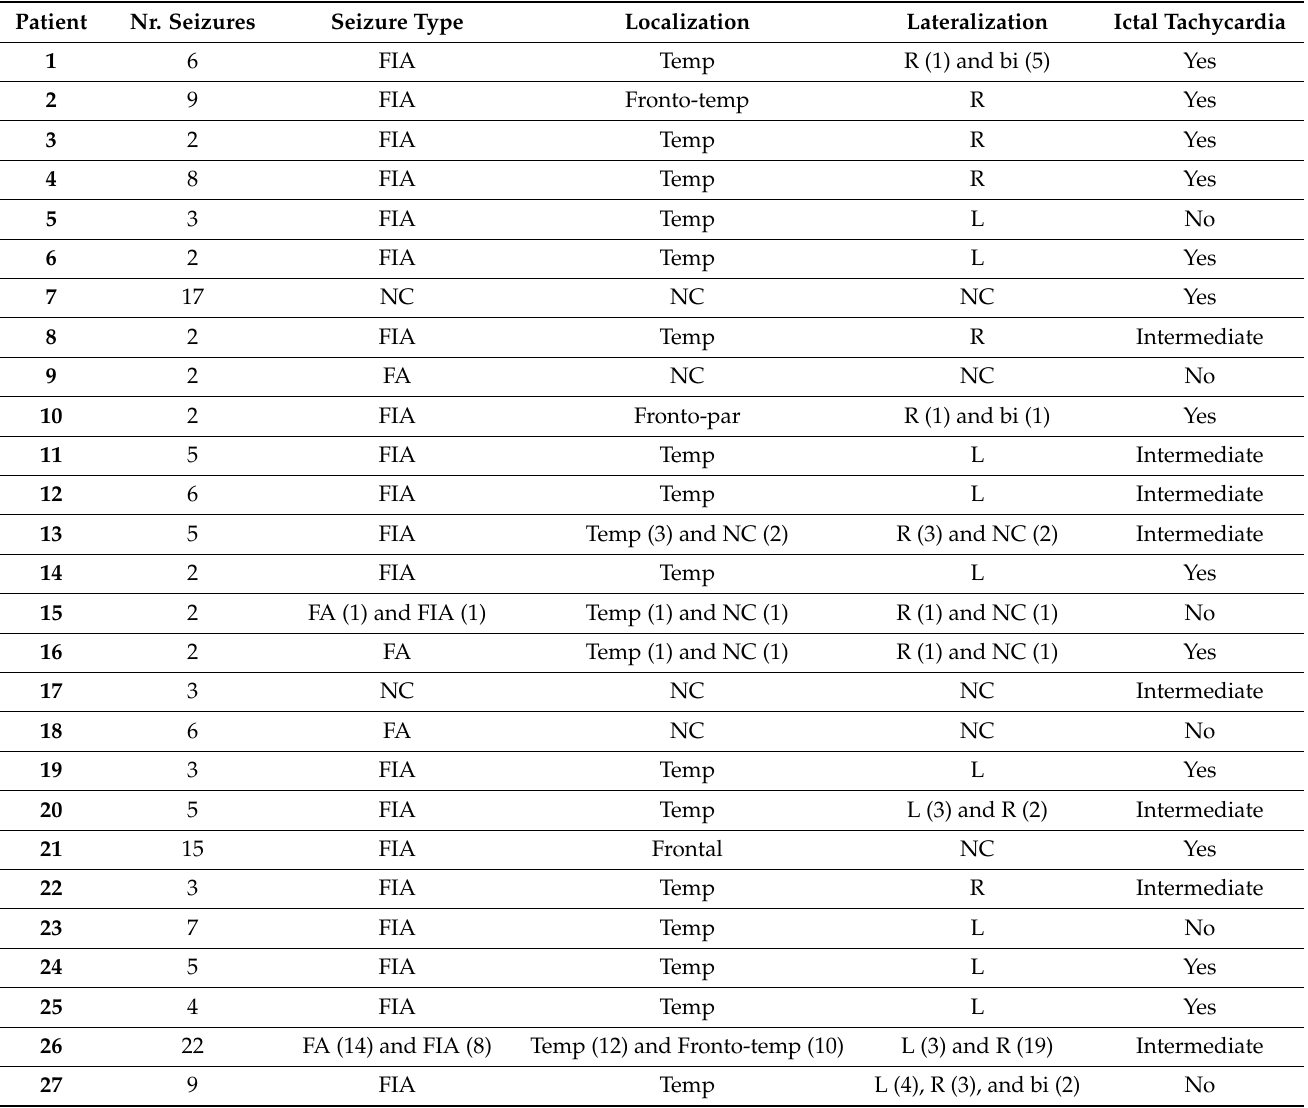
Table 1. The ethical committee of UZL and KU Leuven approved the study, and all patients signed an informed consent form for their participation. Table 1. Overview of the dataset used in the study (SeizeIT1). The table shows the number of seizures, seizure types (FA—Focal Aware, FIA—Focal Impaired Awareness, F-BTC—Focal to Bilateral Tonic–Clonic, or NC—Not Clear), localization (Temp—Temporal, Par—Parietal, Fronto-temp—Fronto- temporal, Fronto-par—Fronto-parietal, Occipito-temp—Occipito-temporal, or NC—Not Clear), later- alization (L—Left, R—Right, bi—bilateral, or NC—Not Clear), and presence of ictal